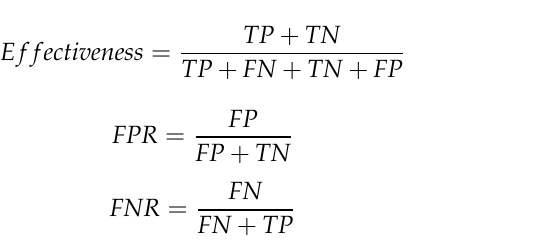
Figure 5. Effectiveness confusion matrix.